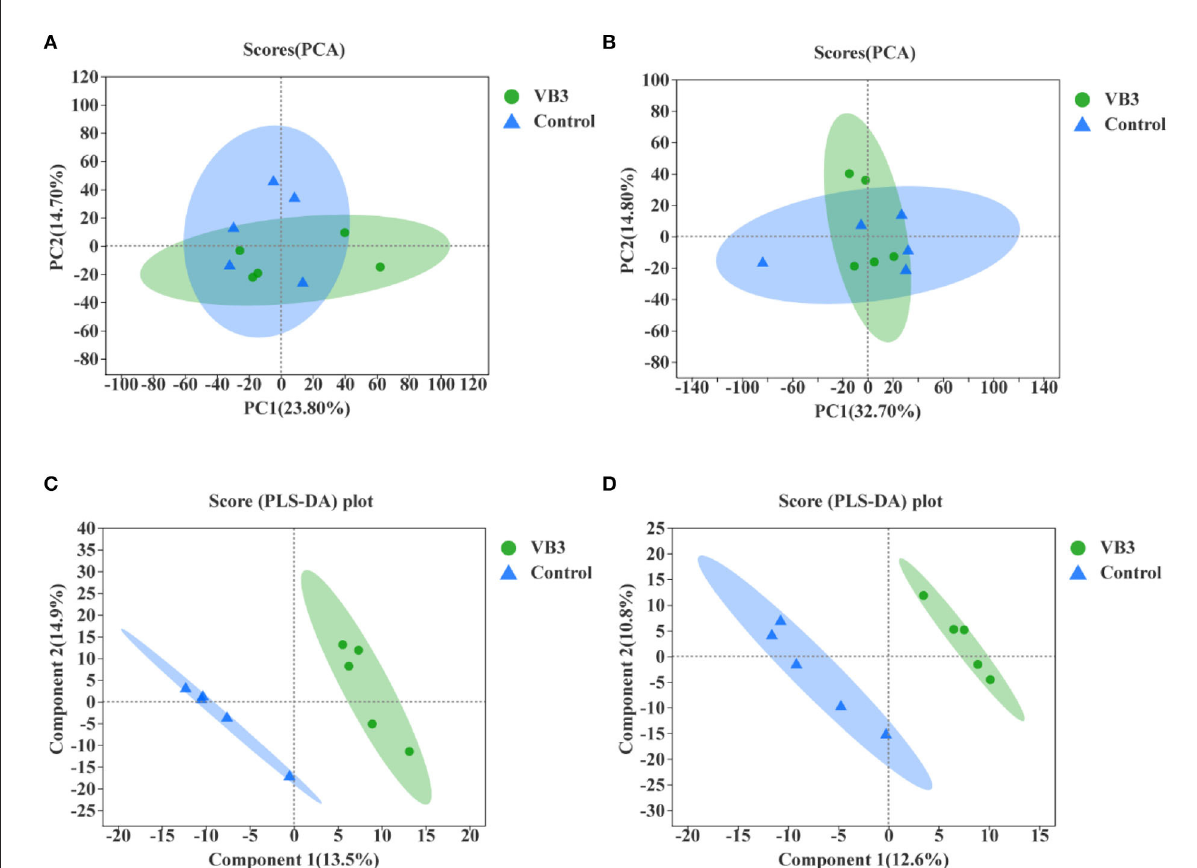
FIGURE4 Principal component analysis (PCA) between the experimental group (VB3) and control group (Control) and partial least squares discriminant analysis (PLS-DA) between the experimental group (VB3) and control group (Control). (A) PCA based on positive ion table. (B) PCA based on negative ion table. (C) PLS-DA based on positive ion table. (D) PLS-DA based on negative ion table.